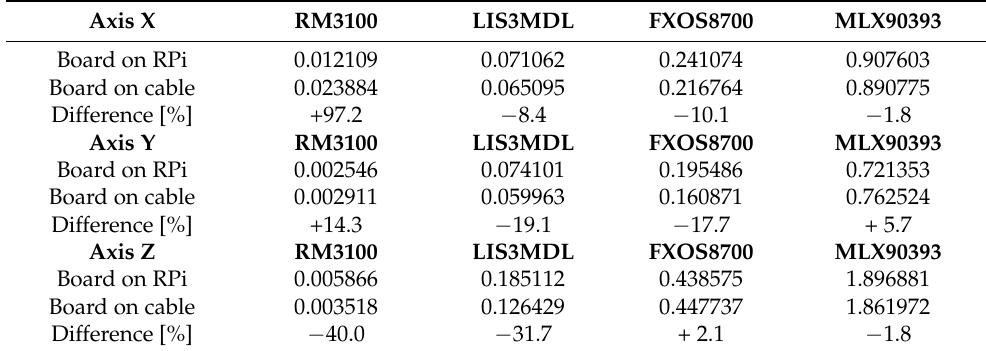
Table 3. Variance of noise for joint measurements [ µ T 2